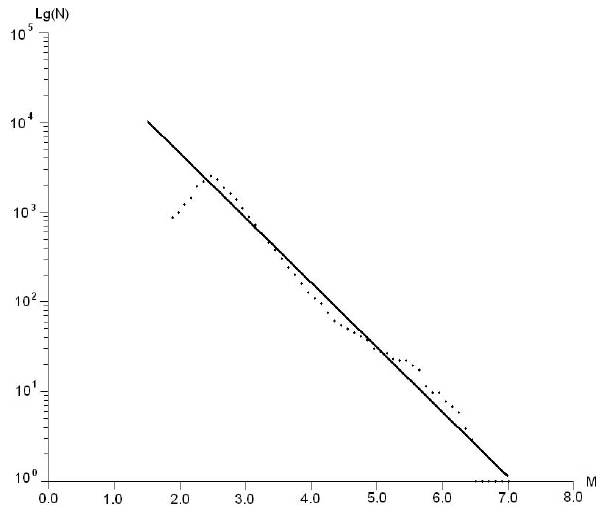
Fig. 3. Magnitude-frequency relationship of the seismicity in Lijiang area during the period 1984–2000.